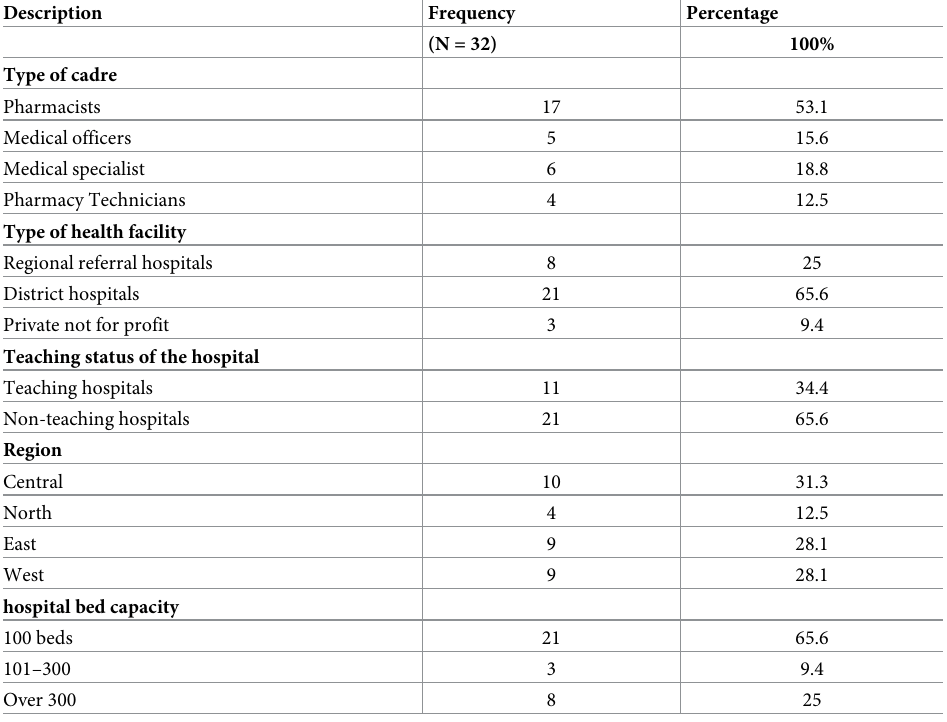
Table 1. Characteristics of the study population (N = 32).